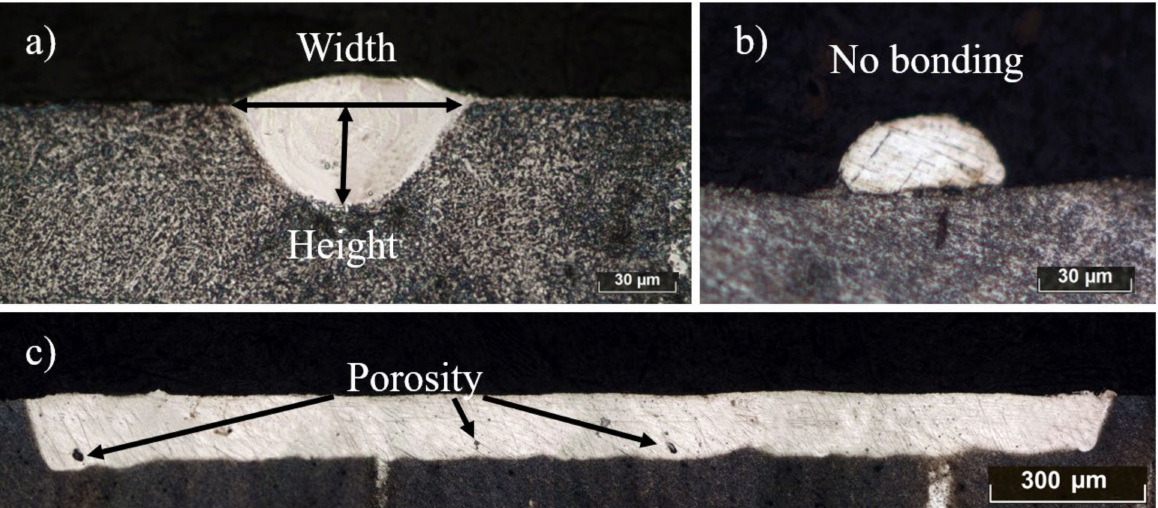
Figure 7. Cross-sections of NiTi single-track deposits: ( a ) common shape of the melt pool for the SLM process; ( b ) no bonding defect; ( c ) appearance of the pores during keyhole mode in the longitudinal